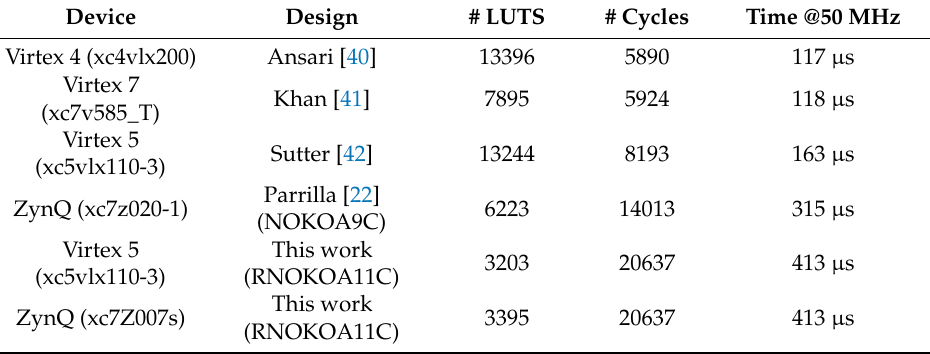
MP_ECC_B-233_RNOKOA11C implementation results and comparison to other